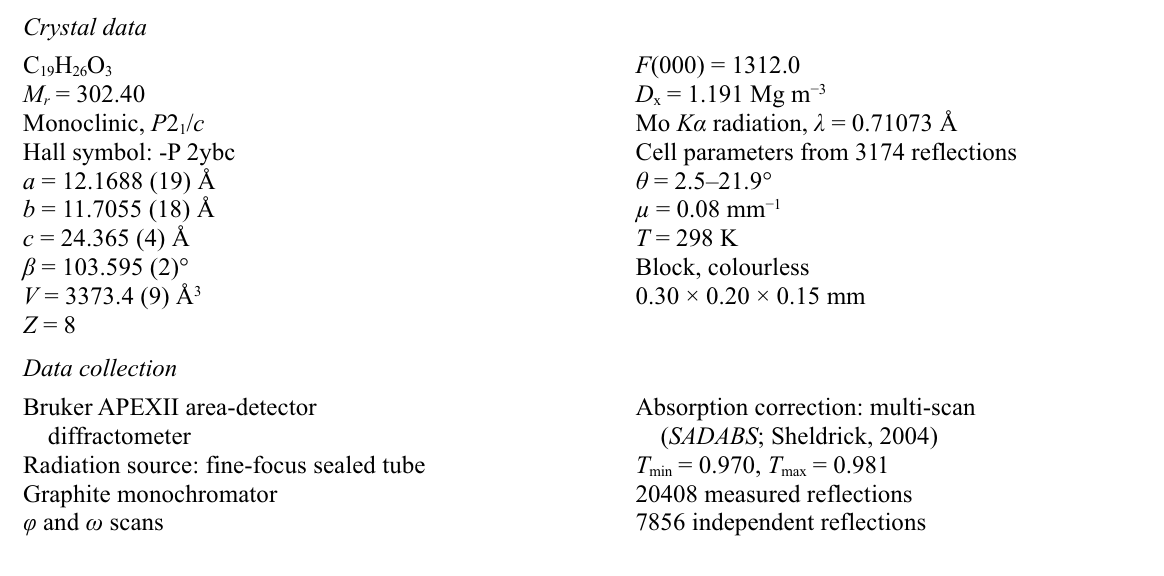
View of the title compound showing the atom-labelling scheme. Ellipsoids are drawn at the 50% probability level. 3,3,6,6,9,9-Hexamethyl-2,3,4,5,6,7,8,9-octahydro-1 H